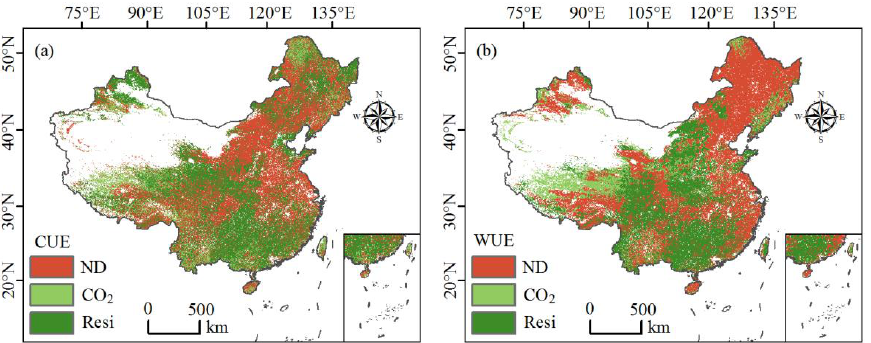
Figure 6. ND and CO 2 and residual factors for the main control area of CUE and WUE. ( a ) ND and CO 2 and residual factors for the main control area of CUE, ( b ) ND and CO 2 and residual factors for the main control area of WUE. Table 2. Main control area and the rate of contribution of ND, CO 2 , and Resi in different areas to CUE and WUE. Qinghai–Tibet Plateau: QT; South area: SA; North area: NA; Northwest area: